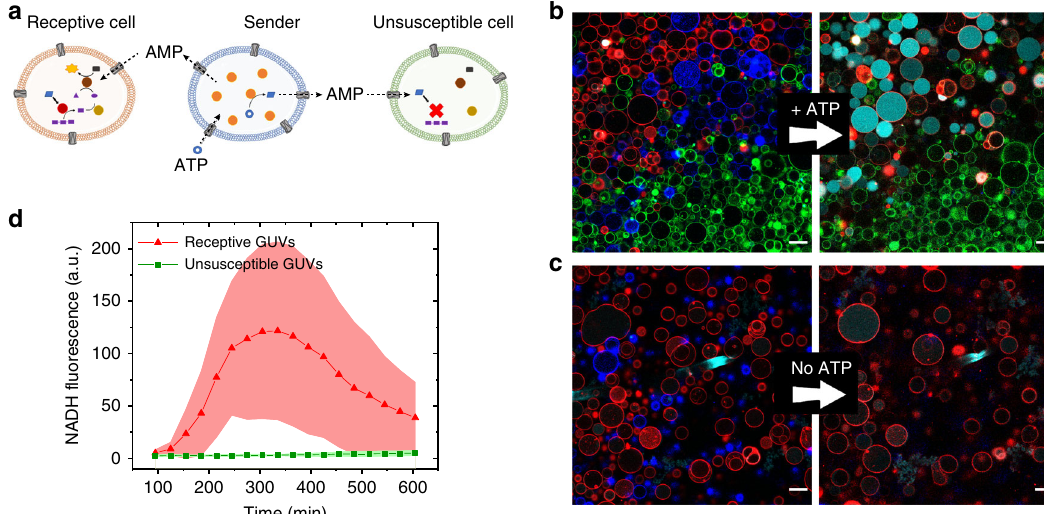
Fig. 6 Selective signalling to receptive arti fi cial cells. a Differential activation of receptive and unsusceptible Receivers by ATP-triggered Senders. Only the receptive Receivers can be activated by the Senders, whereas the unsusceptible Receivers cannot recognize the signal and remain inactive. b , c CLSM micrographs of Senders and Receivers triggered with 2.6 mM ATP ( b ), or without ATP ( c ); before ATP and Na 2 HPO 4 addition (left) or 270 min after (right). Overlay of NADH (cyan), Sender GUVs (blue), receptive Receivers (red), unsusceptible Receivers (green). Scale bars represent 30 µ m. After 270 min the blue Cy5-signal had decreased due to bleaching, but the Senders were still present. d Differential activation of the two subtypes of Receivers, extracted from the time-lapse CLSM micrographs. Error bars depict the SD from 15 Receivers. The decrease in NADH fl uorescence after the initial activation was caused by gradual ef fl ux of NADH through the α HL